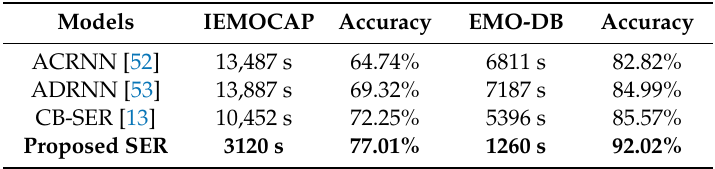
Table 7. The comparison of the proposed model in term of time complexity and accuracy using the suggested speech datasets with the baseline SER methods.